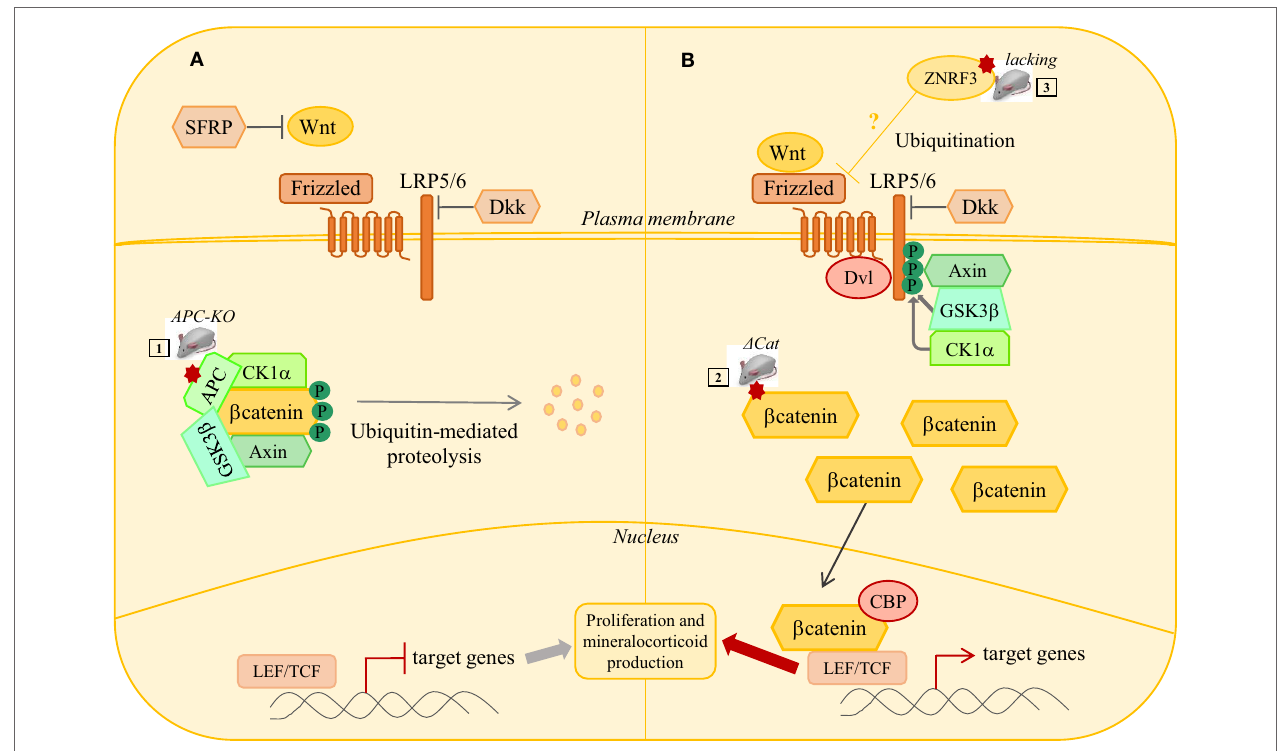
FiGURe 2 | wNT/ β -catenin signaling pathway in adrenal tumorigenesis . (A) In the absence of Wnt ligands, b-catenin is phosphorylated by a complex composed of GSK3b, CK1, APC, and AXIN. This phosphorylation targets b-catenin to proteosomal degradation, thus preventing its nuclear translocation. In this context, the T cell-specific factors (Tcf)/lymphoid enhancer-binding factor (Lef) represses target genes expression through association with transcriptional inhibitors. Secreted frizzled related proteins (SFRP) can inhibit extracellular Wnt signaling. (B) When WNT signaling is active, binding of Wnt ligands to their receptor complex (Frizzled/LRP5/6) induces the recruitment of Disheveled (Dsv) to the cytoplasmic domain of Frizzled and the phosphorylation of the cytoplasmic tail of LRP5/6 by CK1 and GSK3b. This induces delocalization of Axin to LRP5/6 and sequestration of the degradation complex. b-catenin degradation is, thus, reduced and it accumulates. Accumulated b-catenin enters the nucleus, binds to LEF/TCF transcription factors, and activates transcription of target genes. Mutations in several members of WNT/ β -catenin signaling pathway have been identified in adrenal hyperplasias, adenomas, and carcinomas. Several mouse models have been developed to induce constitutive β -catenin activation either through adrenal cortex specific loss of Apc (1) or the expression of a protein resistant to phosphorylation and ubiquitin-dependent degradation (2). Loss of ZNRF3, a potential Wnt signaling inhibitor, has been identified as the major genetic alteration in adrenal carcinoma. Mouse model with adrenal specific inactivation of Znrf3 is required to assess its causal involvement in